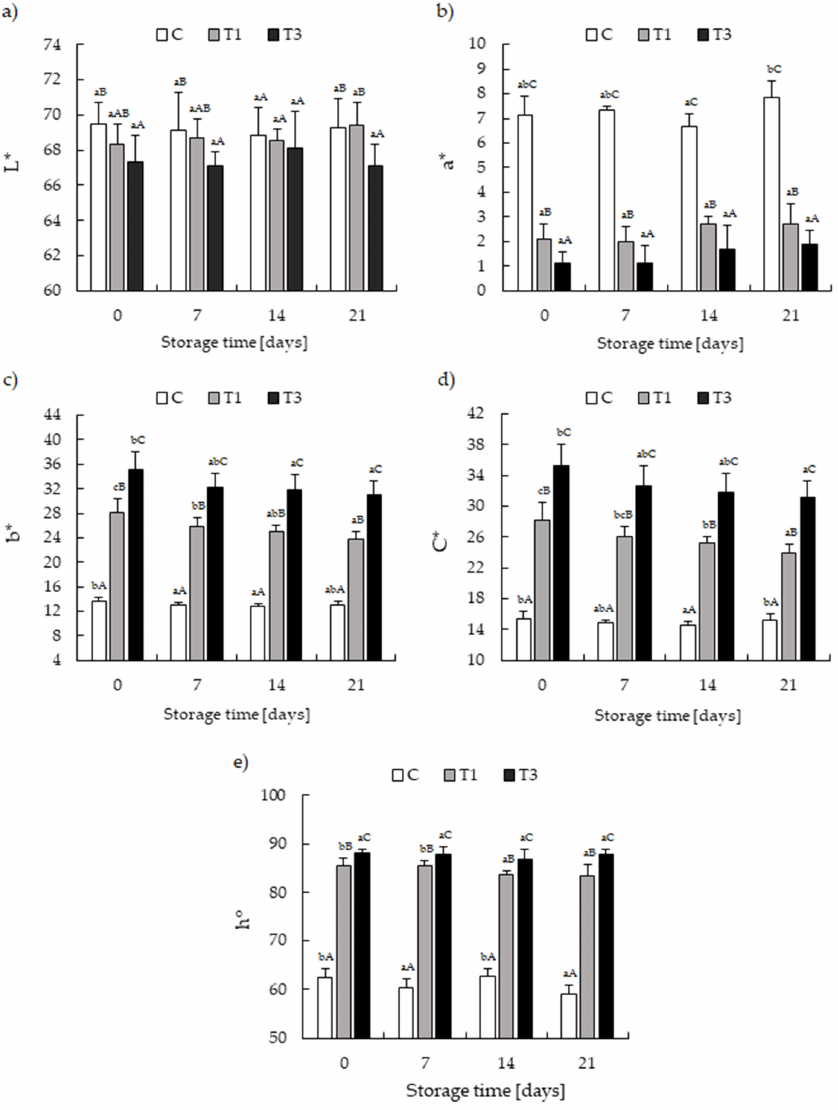
Figure 1. The effect of different concentrations of turmeric and storage time on the color parameters of hermetically packed pork meatloaf: ( a ) L* values; ( b ) a* values; ( c ) b* values; ( d ) C* (saturation); ( e ) h ◦ (hue angle). Samples: C–control; T1–with 1% turmeric rhizome; T3–with 3% turmeric rhizome. Different A,B,C letters indicate a significant difference on subsequent assessment days at p < 0.05. Different a,b,c letters indicate significant differences during storage at p <